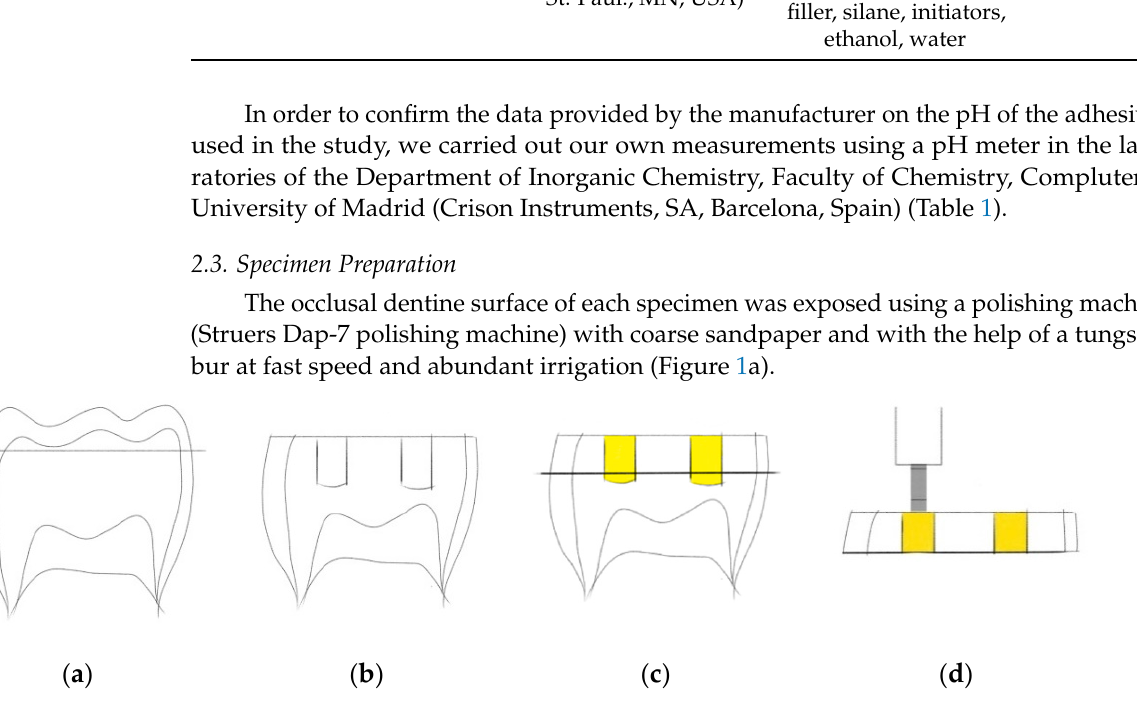
Figure 1. Illustration of specimen preparation and mechanical test of the study. ( a ) Enamel elimination; ( b ) cavity preparation; ( c ) cavity filing and sample cutting; ( d ) micro push-out test.